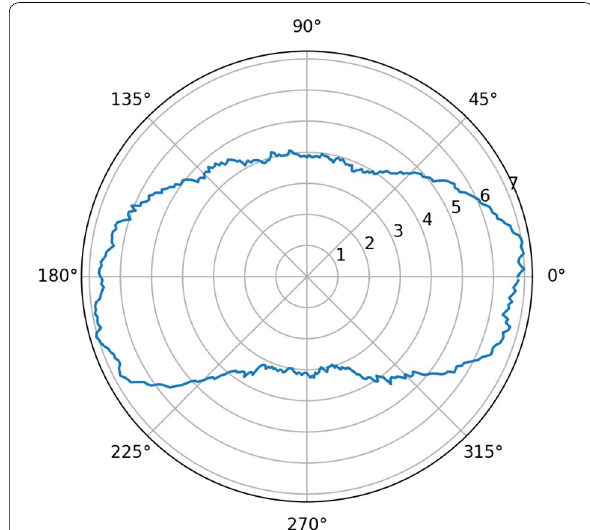
Fig. 4 A graph showing the difference between the error of the contour of the correct pair of MR-TRUS and the error of the contour of the incorrect pair. (Units are pixels) It can be seen that the side of the prostate affected by probe pressure differs in the degree of error between the correct and incorrect pairs of MR-TRUS images